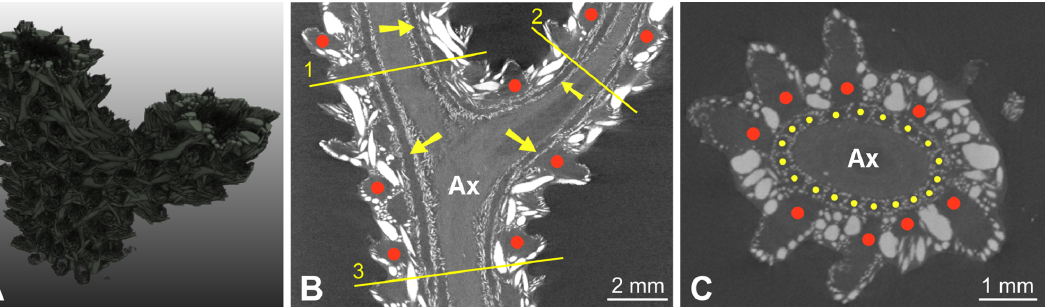
Figure 3. M5 dataset. (A) volume rendering, (B) example of longitudinal slice, (C) axial slice corresponding to the lowest initialization plane. The lines superimposed onto the image represent the location of the initialization planes. The gorgonin axial skeleton was marked ‘‘Ax’’ and the calcite sclerites appear as bright spots of variable size and shape. Examples of polyps were highlighted by red dots. Canals were indicated by yellow arrows in the longitudinal view and by yellow dots in the cross-sectional